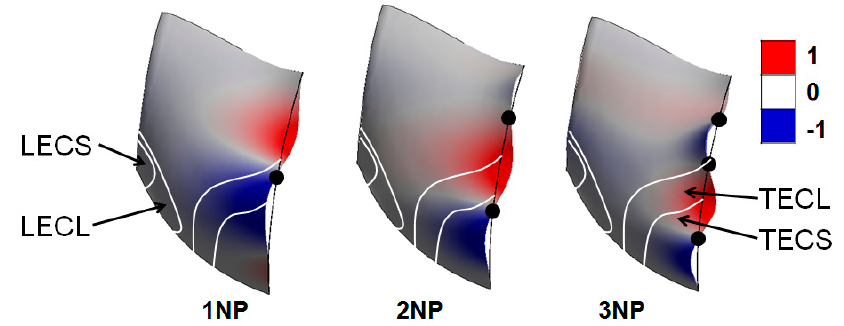
Figure 10. Cavity locations marked on the mode shape graphs of the single blade.